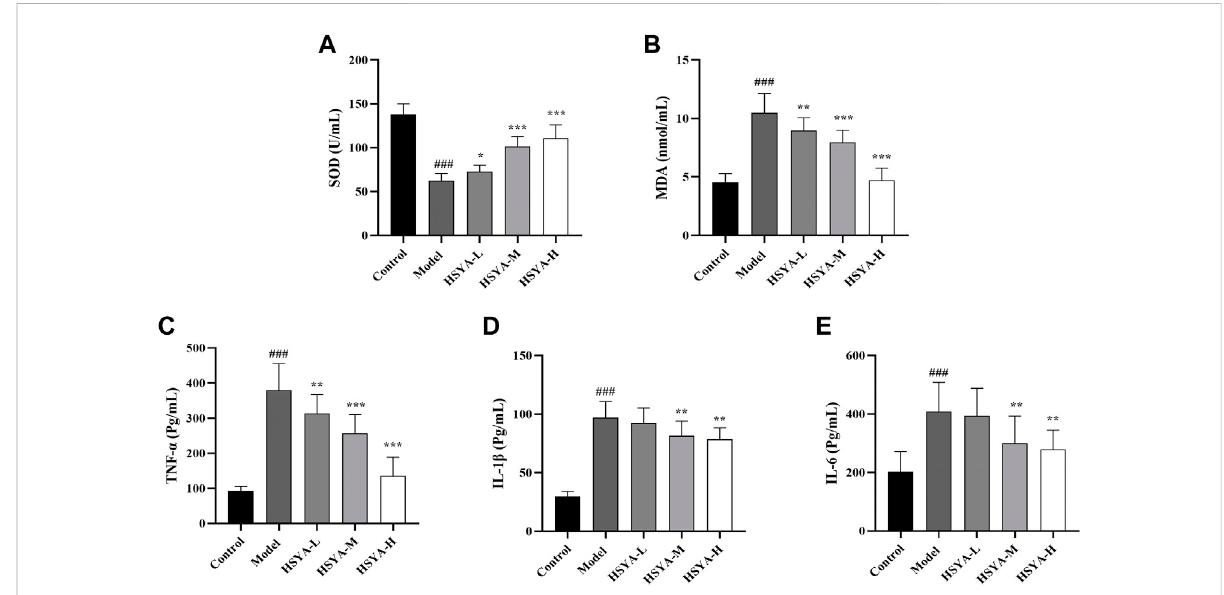
FIGURE 5 Effects of HSYA on the liver tissue pathology. (A) Control; (B) Model; (C) HSYA-L; (D) HSYA-M; (E) HSYA-H; (F) Hepatocyte necrosis quanti fi ed ( (cid:1) x ± s , n = 3). ## p < 0.01 vs. the control group; * p < 0.05 vs. the model